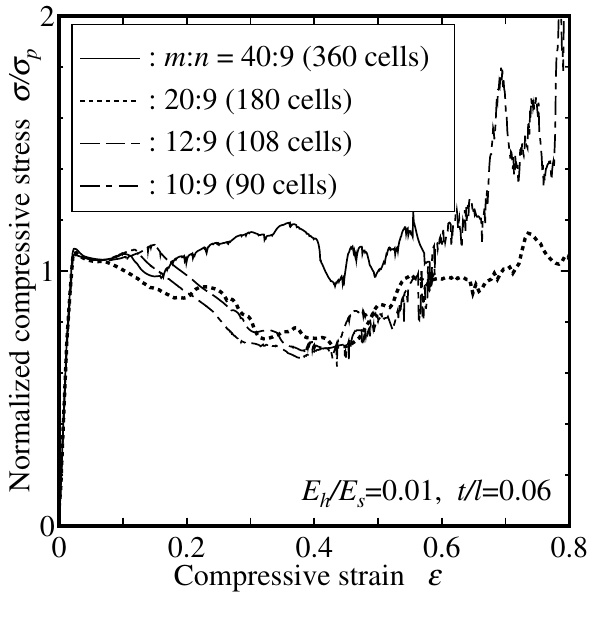
Figure 12. Stress-strain responses for various honeycomb widths under the same cell’s thickness to length ratio t/l = 0 . 06 .